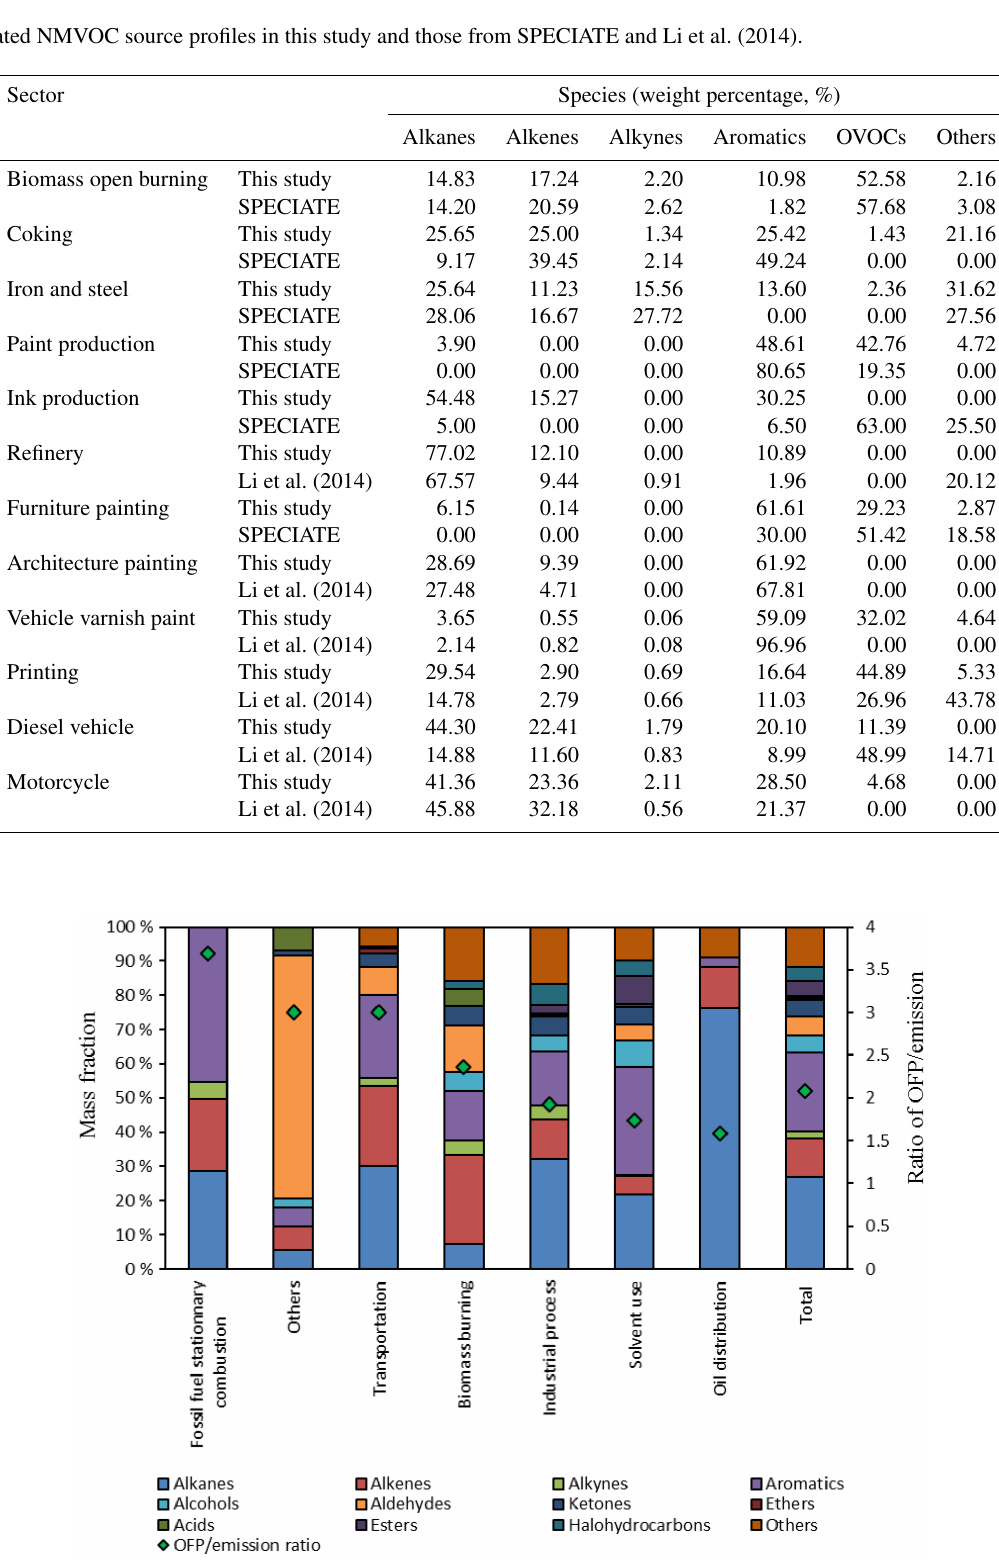
Figure 3. Fractions of NMVOC species and the ratios of OFPs to emission by sector for Jiangsu in 2014.